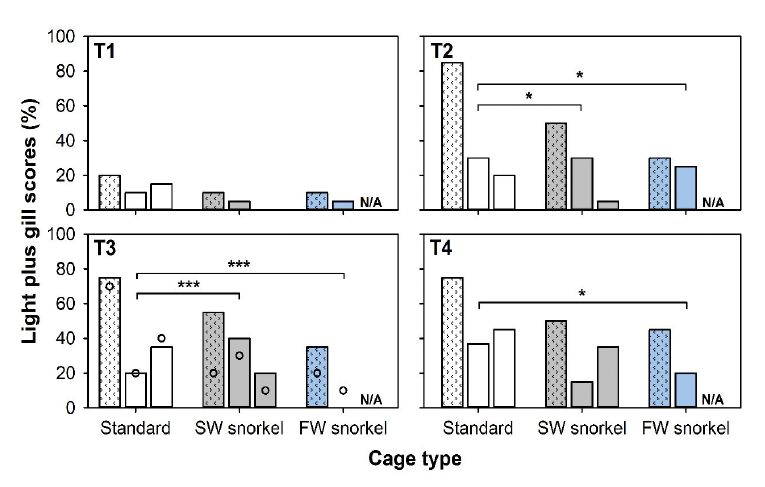
Fig. 2. Proportions of ‘light plus amoebic gill dis- ease (AGD)-related gill scores’ (scores of ≥ 2; see ‘Materials and methods’ for further details) for farmed Atlantic salmon in different cage treat- ments. Results are shown for each replicate (n = 3 replicates) standard (white bars), SW snorkel (grey bars) and FW snorkel cage (blue bars) at Times 1−4. See Fig. 1 legend for details of cage treatments and sampling times. Stippled bars indicate cages positioned closest to other AGD- affected cages at the farm and expected to be un- der increased infection pressure. Open circles at Time 3 denote proportions of Paramoeba peru- rans -positive fish from gill swab PCR analysis of 10 fish in each replicate cage. N/A indicates 1 FW snorkel cage discarded from analyses. *p < 0.05, ***p <